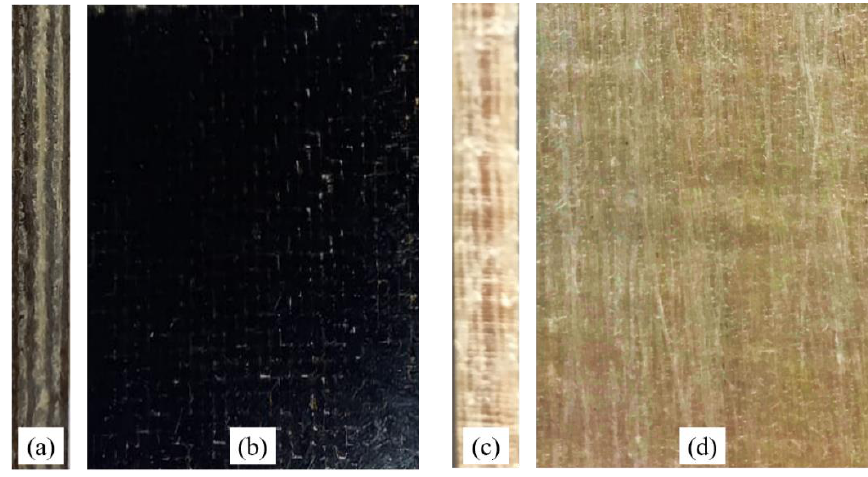
Figure 3. ( a ) Lateral view and ( b ) front view of the B-SFRP; ( c ) lateral view and ( d ) front view of the SFRP.